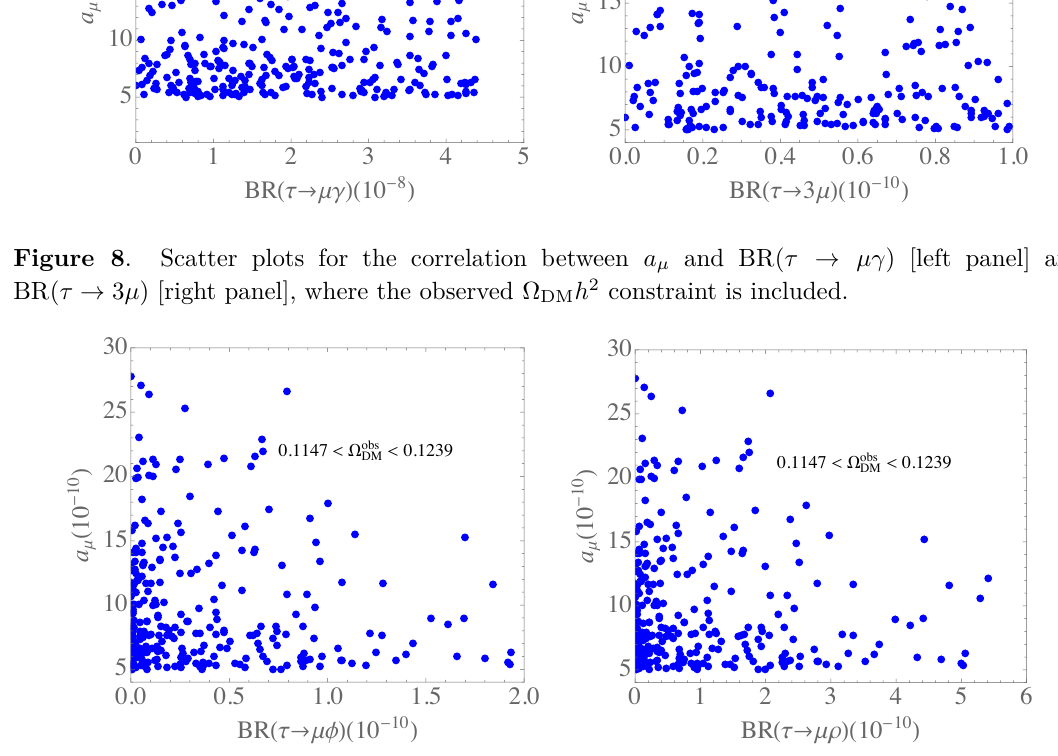
Figure 9 . Scatter plots for a µ versus BR( τ → µφ ) [left panel] and BR( τ → µρ 0 ) [right panel], where the observed Ω DM h 2 constraint is taken into